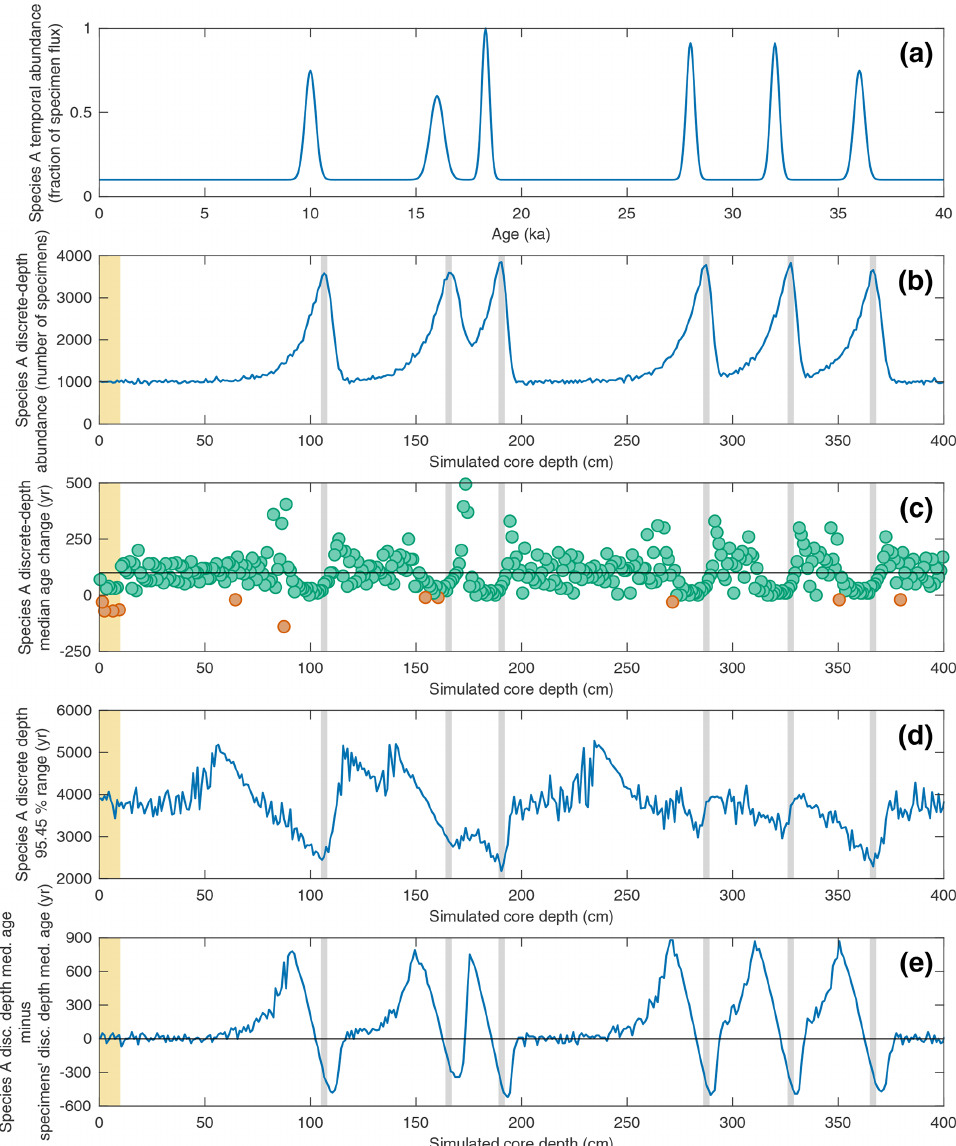
Figure 6. Investigating the effect of temporal changes in a species’ abundance upon its discrete-depth age–depth signal in the case of a simulated sediment core with a constant SAR of 10cmkyr − 1 and constant BD of 10cm. In all panels, the yellow interval denotes the still- active BD (10cm) at the core top. (a) The temporal abundance for a given species “Species A” used in the SEAMUS simulation, inputted into the model as a fraction of the per time step specimen flux. (b) The resulting simulated downcore, discrete-depth (1cm) absolute abundance (number of specimens) for Species A. Vertical grey bands correspond to the depth of the abundance peaks. (c) The downcore, discrete-depth (1cm) change in median age based on samples containing only Species A specimens. Green circles denote downcore increase in discrete- depth apparent median age (i.e. positive apparent SAR) and orange circles denote downcore decrease in discrete-depth median age (i.e. apparent age reversals). The horizontal black line in each panel denotes the perfect downcore age change of + 100yrcm − 1 that would be associated with a constant SAR of 10cmkyr − 1 . (d) The 95.45% age range of for Species A for each discrete 1cm depth. (e) The offset between the median age of Species A (Med A ) and the median age of all specimens (Med all ). Shown in the panel is Med A − Med all . The horizontal black line corresponds to zero (i.e. no